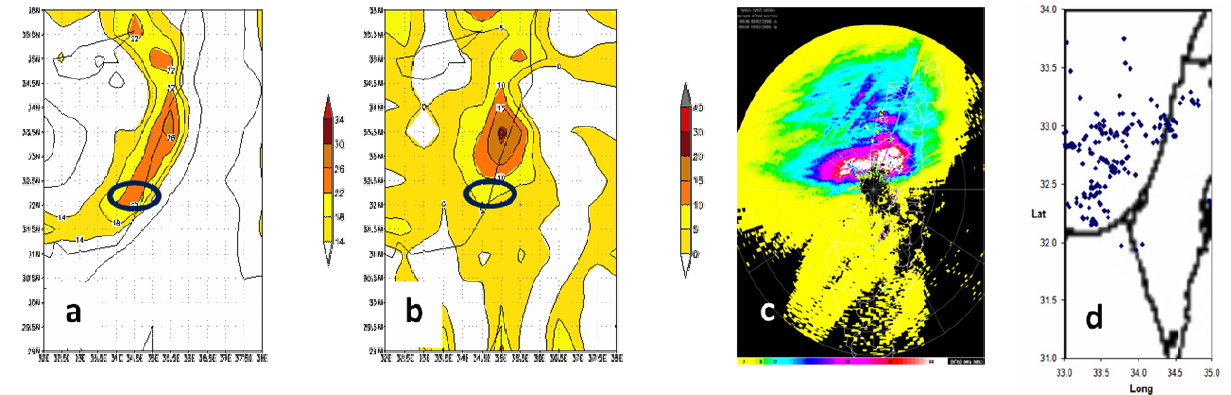
Fig. 5. Same as Fig. 3. The MKI and RDI are for 8 February 2006, 18:00UTC. The radar derived rainfall and the lightning locations are integrated over 17:20–19:20UTC. The bold ellipses in (a) and (b) denote the location of the heaviest rain.